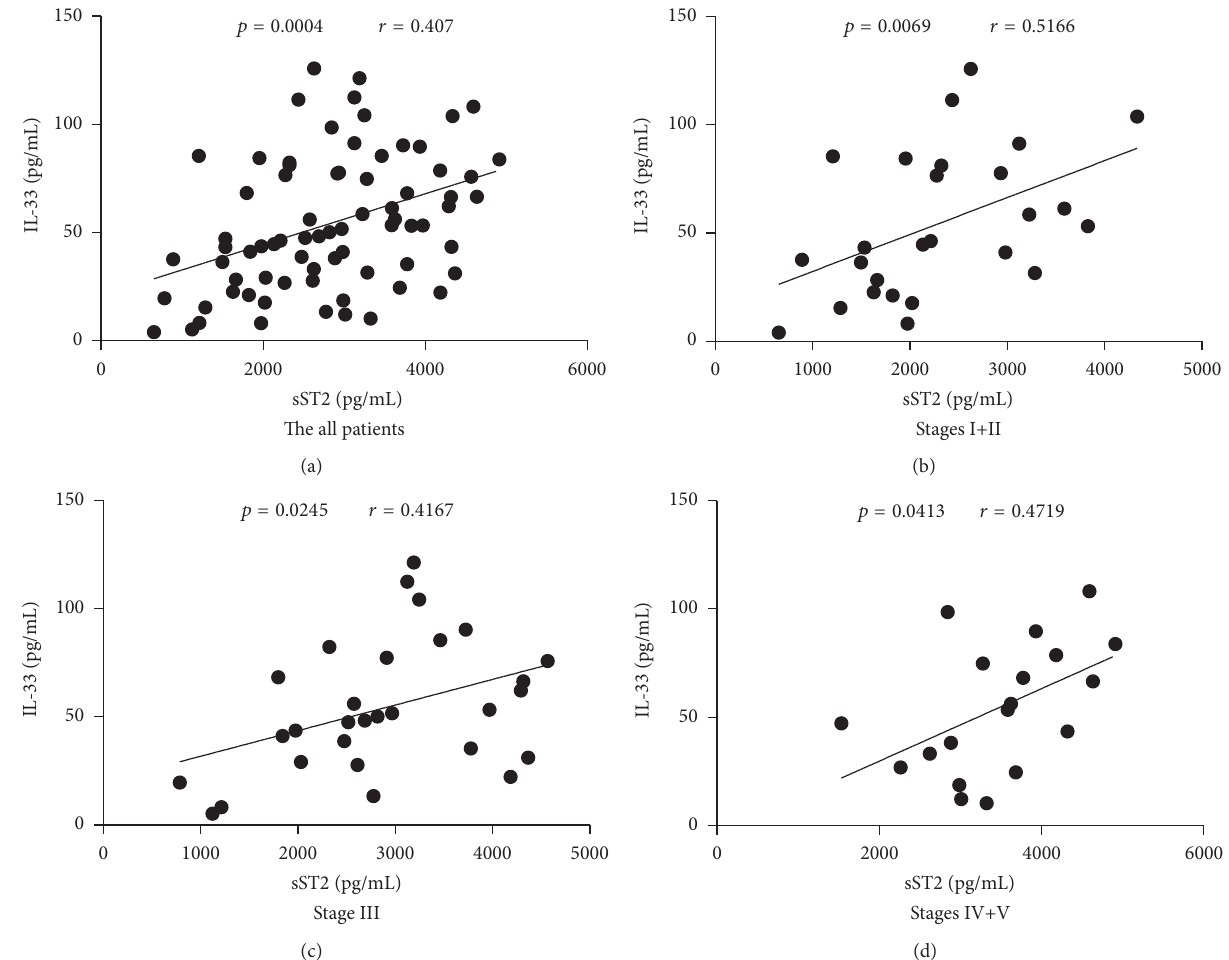
Figure 2: Correlation analysis of serum sST2 with IL-33 levels in IgAN patients. The potential relationships between sera sST2 and IL-33 levels in IgAN patients were analyzed by Spearman correlation tests. Data shown are the mean concentration of individual subjects from two separate experiments. ((a)–(d)) Serum sST2 was positively correlated with IL-33 levels in all patients and also in Stage I+II, Stage III, and Stage IV+V of IgAN